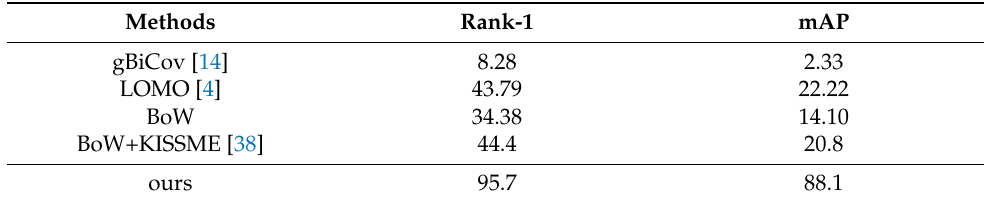
Table 2. The comparison results with traditional methods on Market-1501 dataset.